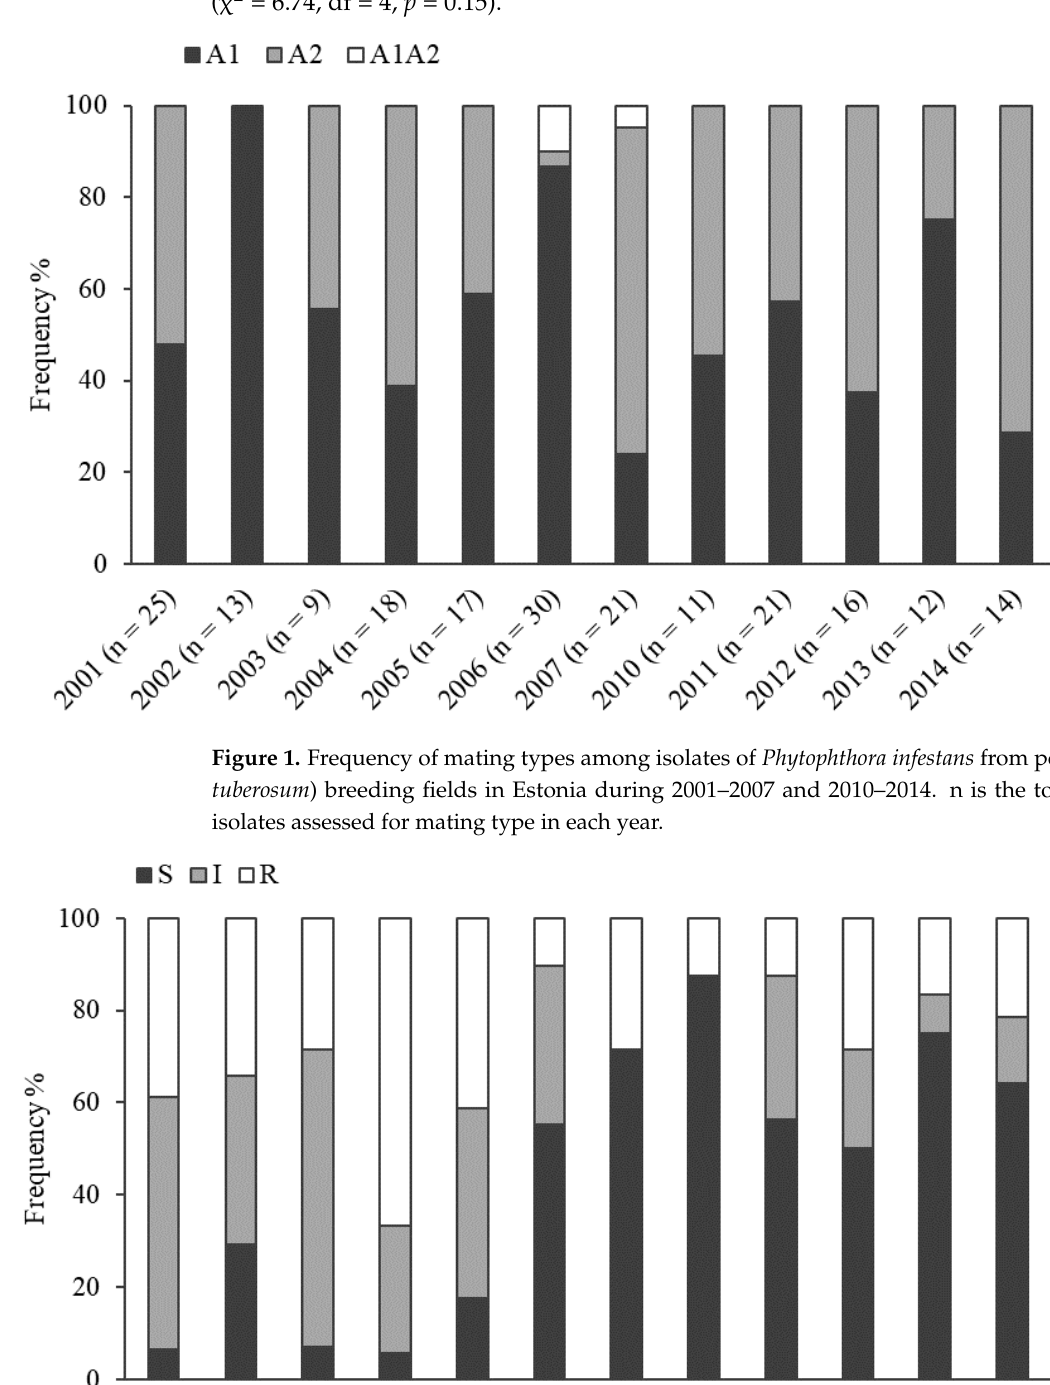
Figure 3. Correlations between the percentage of P. infestans isolates with different metalaxyl re- sistance and year of study in potato breeding fields in Estonia for 2001 to 2014. Metalax- yl-sensitivity as: S—sensitive; I—intermediate; and R—resistant. Data were fitted by linear regres- sions. S: y = 4.82 x − 9620, r 2 = 0.57, p = 0.005; I: y = − 3.01 x + 6080.4, r 2 = 0.46, p = 0.016; R: y = − 1.80 x + 3640, r 2 = 0.27, and p = 0.087. Within the metalaxyl-resistant isolates, 48 belonged to A1 and 52% to A2 mating types and 54% of metalaxyl-sensitive isolates were A1, 42% A2 mating type, and 4%